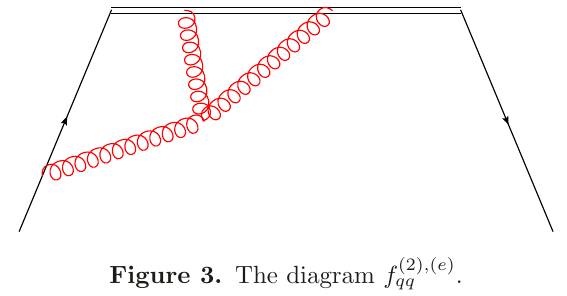
Figure 3. The diagram f (2) , ( e ) qq